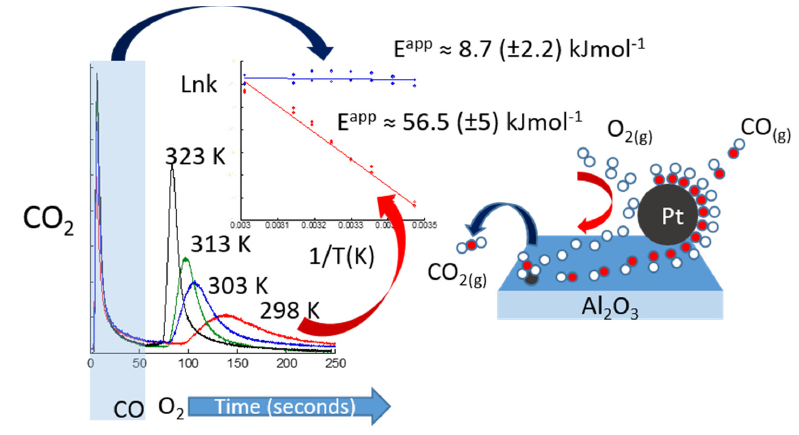
Figure 21. Mechanism for the low temperature oxidation of CO 2 derived from the combined application of time resolved XAFS, DRIFTS, and MS [168,169]. Isolated Pt atoms are suggested to be the active sites for the formation of reactive carbonate species (DRIFTS). The sites that form these carbonates must be reactivated through the participation of the nanoparticulate Pt also present that acts to supply oxygen to the atomic Pt sites once CO has desorbed from them. Reproduced with permission from J. Am.